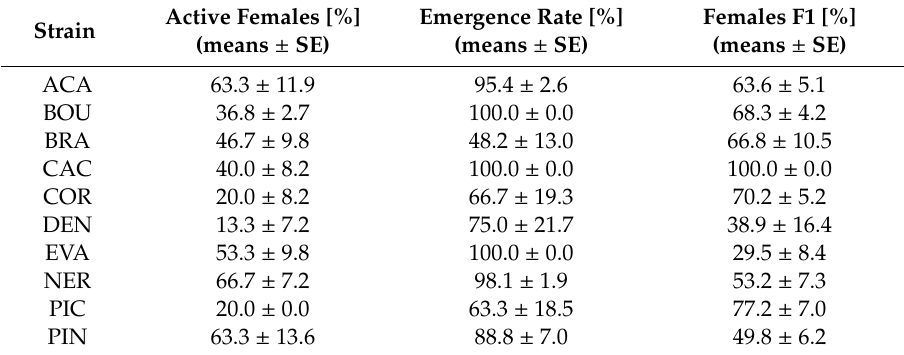
Table 3. Active Trichogramma females (%) ( = parasitizing at least one T. absoluta egg), emergence rate (%) of F1-progeny from parasitized host eggs and proportion of females (%) in the F1-progeny in the host acceptance test. Ten eggs of T. absoluta were o ff ered to each Trichogramma female on a tomato leaf disc for 2 h and then incubated until emergence of the progeny. Arithmetic means ± standard errors (SE) are calculated from three trials per strain, each with 10 females, for active females (%) or from progeny per parasitizing female (up to 30 per strain) for emergence rate (%) and F1-females (%). Active Females [%] Emergence Rate [%] Females F1 [%] Strain (means ± SE) (means ± SE) (means ± SE) ACA 63.3 ± 11.9 95.4 ± 2.6